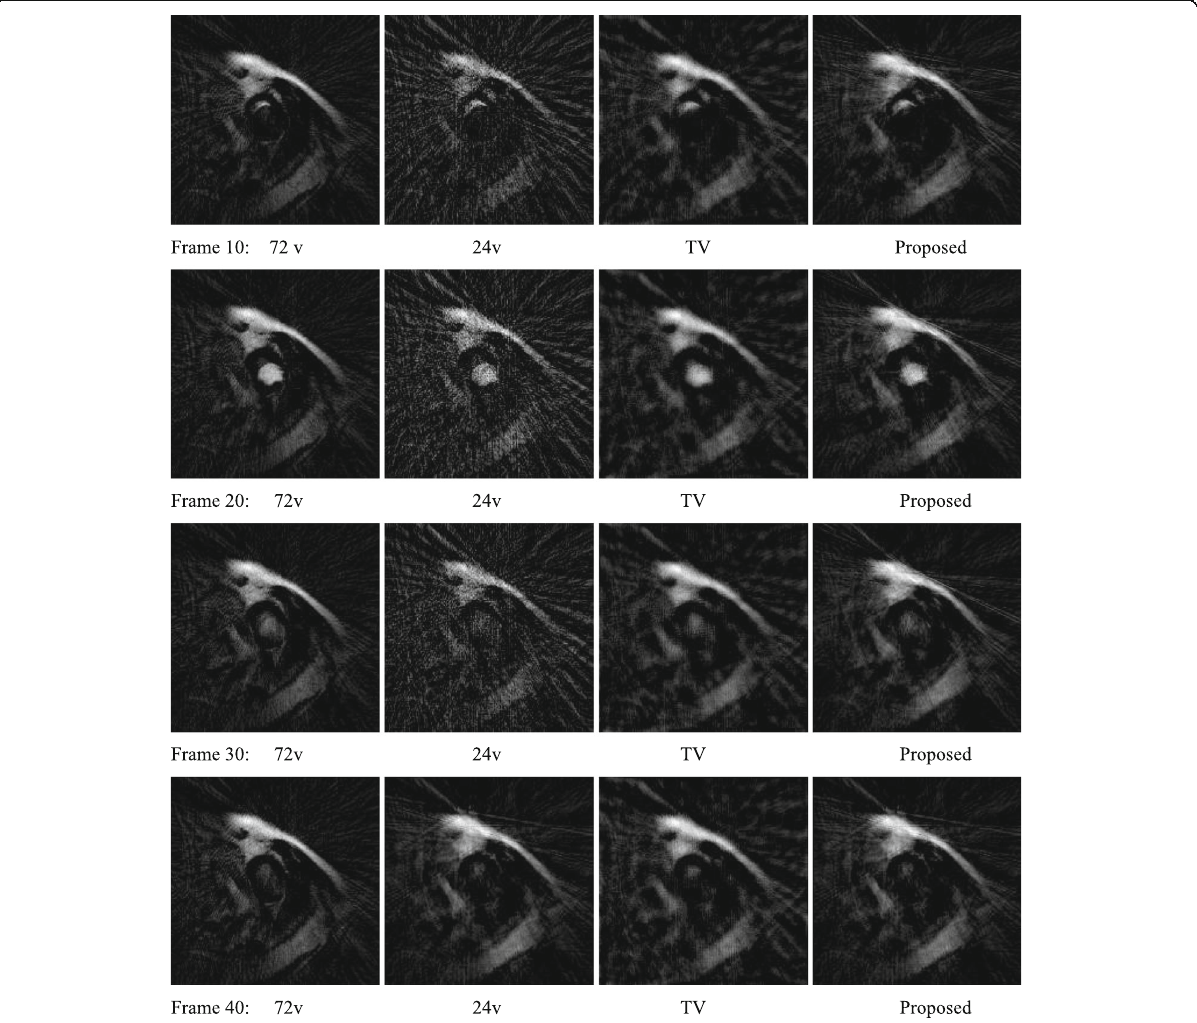
Fig. 4 (Frame 10 ~ 40). MRI patient image reconstructions by using (1st column) 72-view FBP, (2nd column) 24-view FBP, (3rd column) 24-view iterative TV, and (4th column) 24-view proposed method. The 1st column is treated as the gold standard for other columns to compare with. The four rows of images correspond to time frames of 10, 20, 30, and 40,